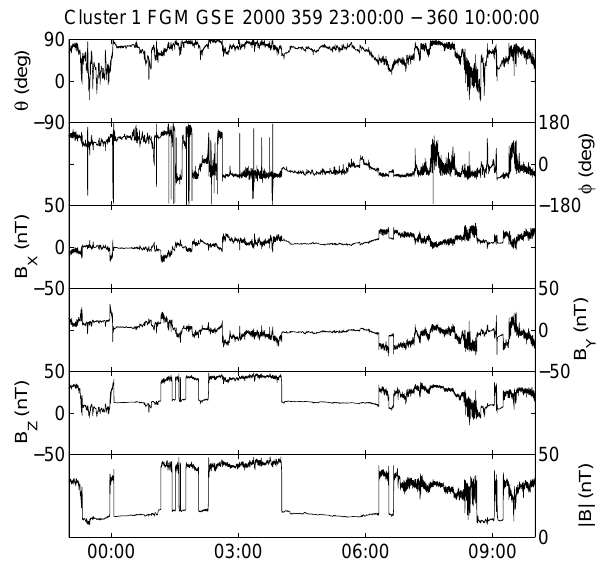
Fig. 1. The magnetic field in GSE coordinates at Cluster 1 from 23:00 on 24 December 2000 until 10:00 on 25